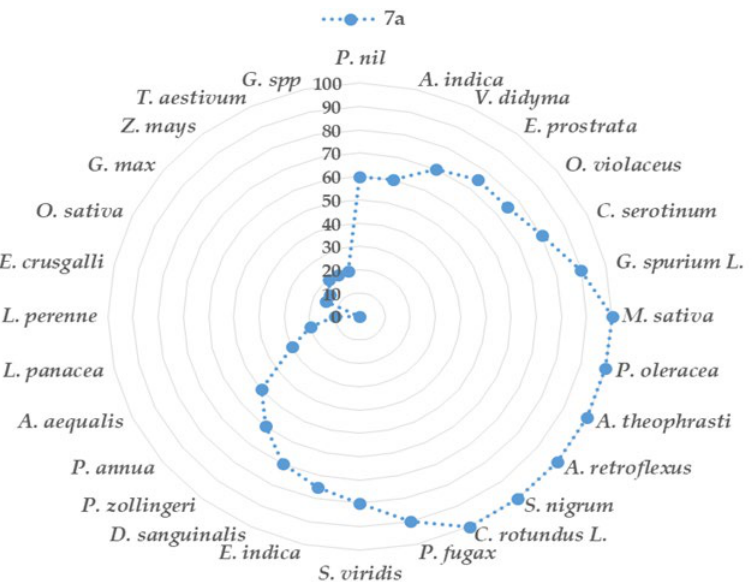
Figure 4. The use of compound 7a at an 18.75 g a.i./hm 2 dose for the post-emergence treatment of broadleaf weeds, grass weeds, and crops.